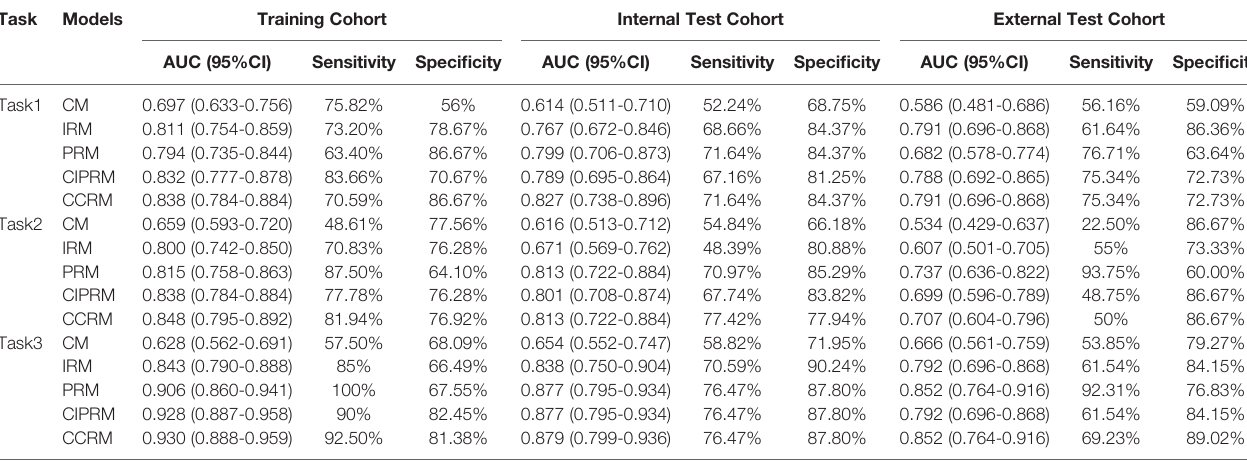
TABLE 4 | Summary of fi ve models ’ performance in training, internal test, and external test cohorts of tasks 1 – 3. Task